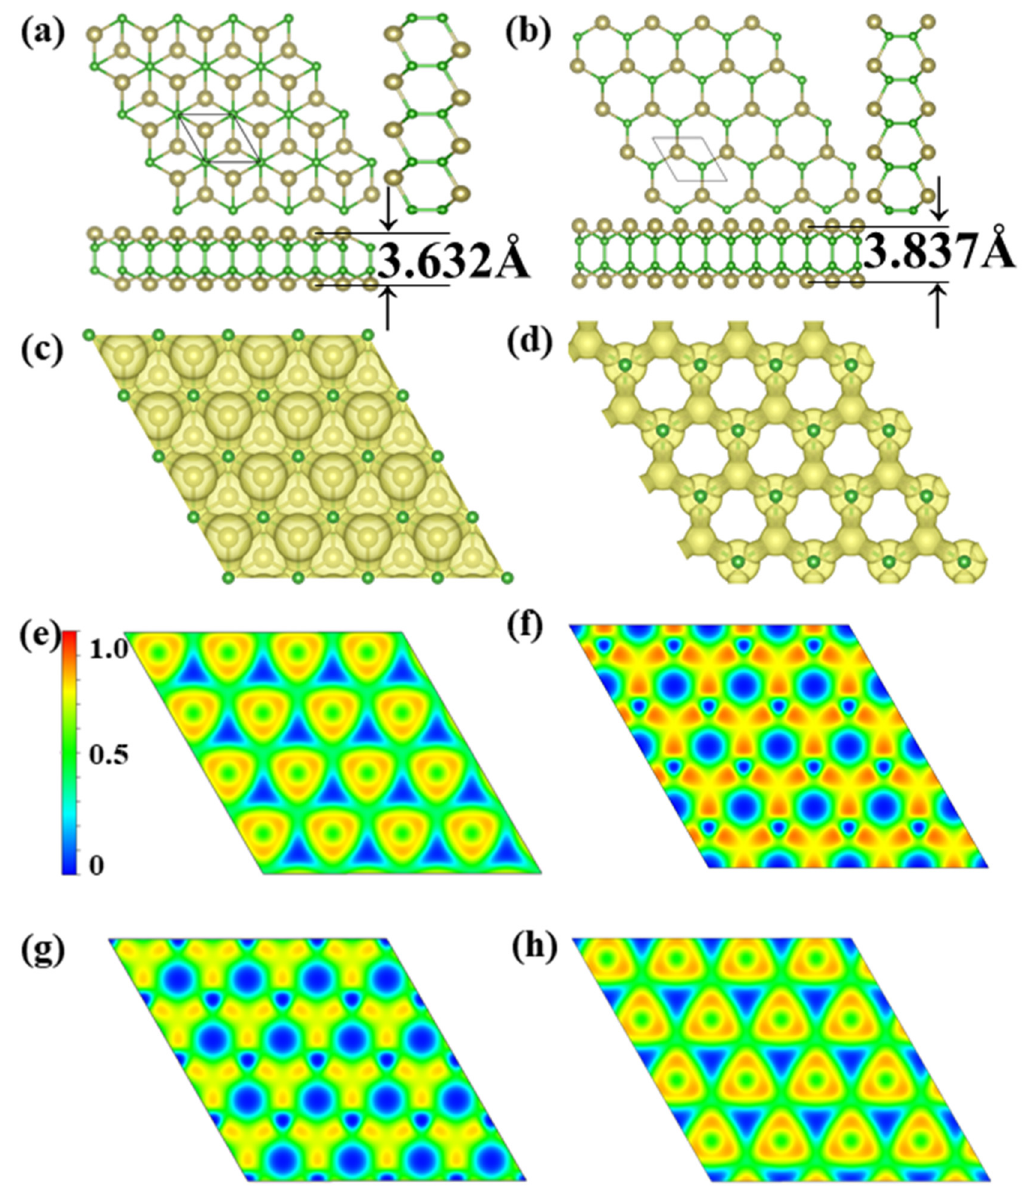
Figure 1. Predicted ( a ) α -TeB monolayer with P -3 m 1 symmetry and ( b ) β -TeB monolayer with P -6 m 2 symmetry. The 3D ELF maps of ( c ) α -TeB monolayer and ( d ) β -TeB monolayer, the isosurfaces of 3D ELFs with the isovalue of 0.75 au. The 2D ELF maps of ( e ) Te-atoms layer and ( g ) B-atoms layer at α -TeB monolayer. The 2D ELF maps of ( f ) Te-atoms layer and ( h ) B-atoms layer at β -TeB monolayer.